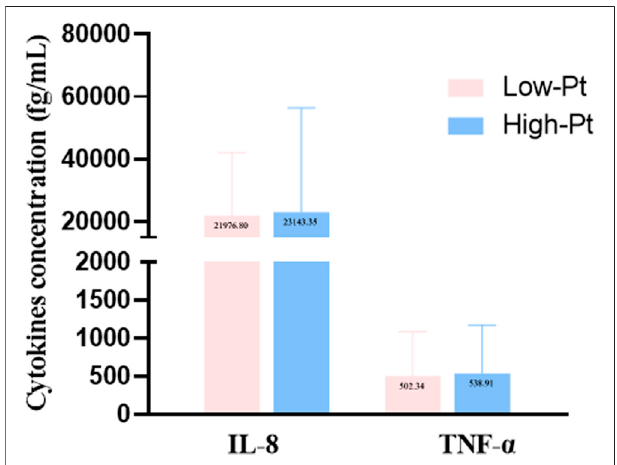
FIGURE 2 | Cytokine levels in the low- and high-platinum groups. Low- Pt group, n (cid:1) 77, High-Pt group, n (cid:1)